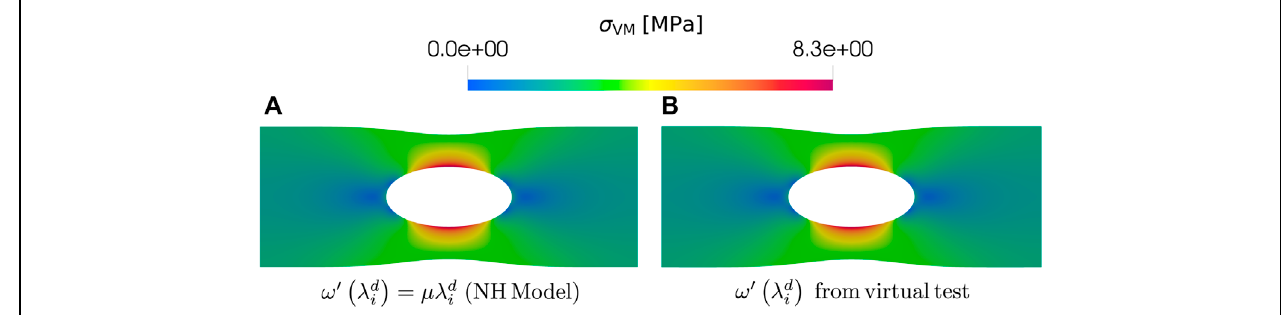
FIGURE 4 | Plot comparing the results of σ VM for the reference Neo-Hookean continuum model and the reverse-engineered one. (A) σ VM using the Neo-Hookean model. (B) σ VM using the ω ′ ( λ d i ) reverse-engineered from the non-homogeneous virtual